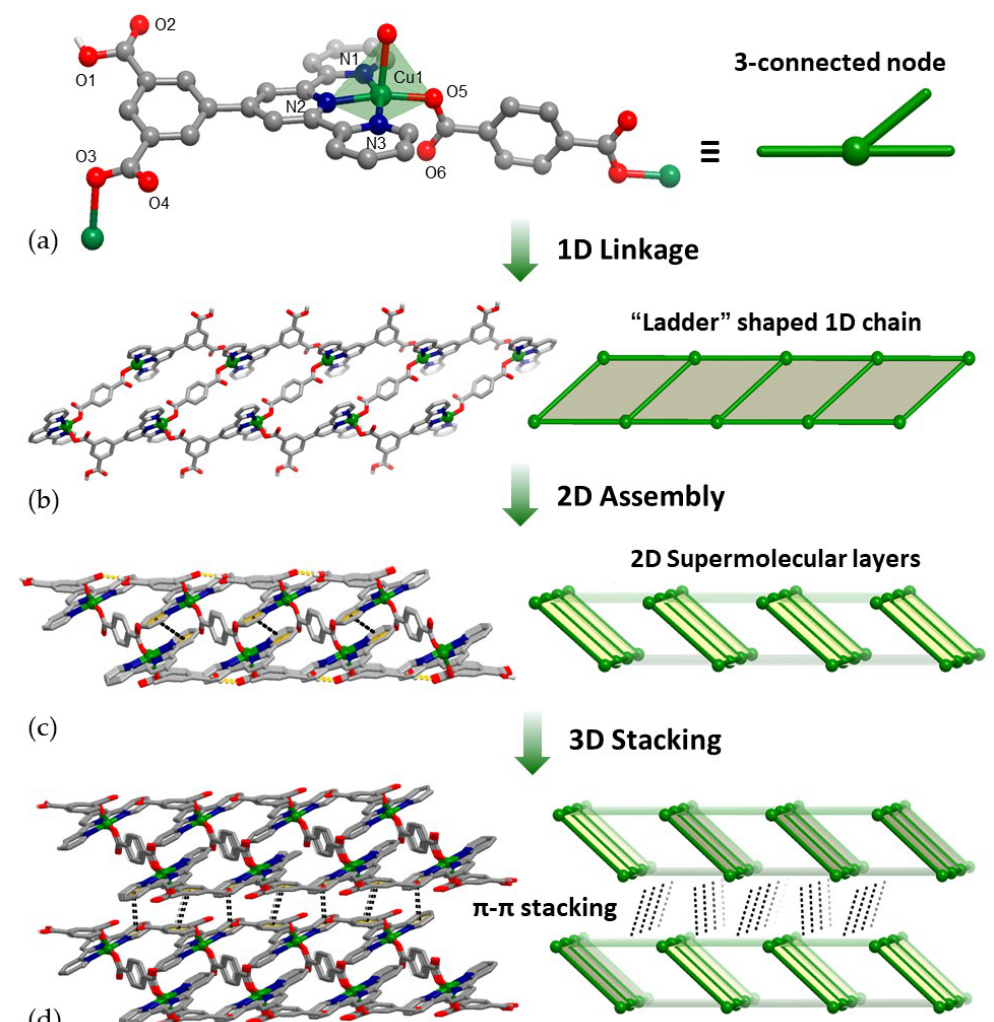
Figure 4. Asymmetric unit of 2 ( a ); the 1D “ladder-shaped” chain structure in 2, as well as the linking mode of the nodes ( b ); a 2D supermolecular layer is formed by the orderly array of the 1D chain ( c ); the 3D structure of 2 ( d ). Some H atoms are omitted for clarity.